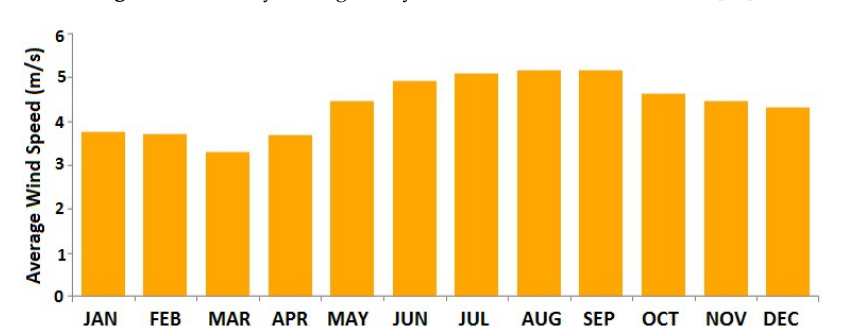
Figure 5. Monthly average daily radiation and clearness index [38].